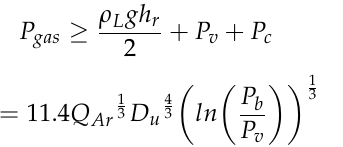
Figure 3. The comparison of the calculated and measured [C] and [O] concentrations during the RH treatment (“[]” indicates dissolved value) [2,9]. 3. Simulation of the Refining Process of ULC Steel The refining process of ULC steel, consisting of LF and RH treatment, was simulated for different deoxidation strategies. The typical European production route for ULC steel is based on the decarburization of non-deoxidized steel in RH and subsequent deoxidation with Al at the late stage of RH treatment [17]. The simulations were targeted to theoretically evaluate the influence of carbon pre-deoxidation followed by Al deoxidation compared to the single Al deoxidation for the inclusion population (volume fraction). Ti is widely applied to stabilize ULC steel, which is realized by FeTi addition after deoxidation. It is known that Ti-stabilized ULC steel has a higher clogging tendency [18,19]. FeTi addition on the inclusion content in ULC steel was also discussed based on the simulation results. For the simulations, the steel and slag compositions before the refining were assumed as listed in Table 1. The Fe concentration was 99.772 in mass percent (% mass). Note that the steel and slag were not necessarily in an equilibrium state before refining. Table 2 lists the mass of steel, slag, and the additions in the different simulations. Simulation A was performed under the assumption of only Al deoxidation after RH, while simulation B was performed with the addition of 80 kg carbon for pre-deoxidation during tapping and less Al addition to achieve a similar final Al concentration in the steel; simulation C was